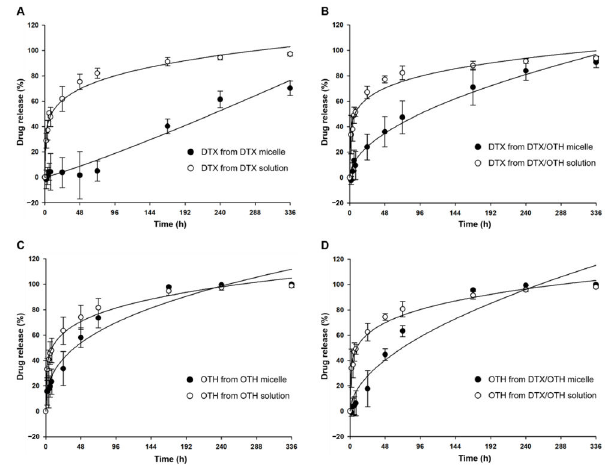
Figure 2. Single and combined drug-release profiles of docetaxel (DTX) and osthol (OTH). ( A ) DTX release in DTX-loaded mPEG- b -PCL micelles and DTX solution, ( B ) DTX release in DTX/OTH- loaded mPEG- b -PCL micelles and DTX/OTH solution, ( C ) OTH release in OTH-loaded mPEG- b -PCL